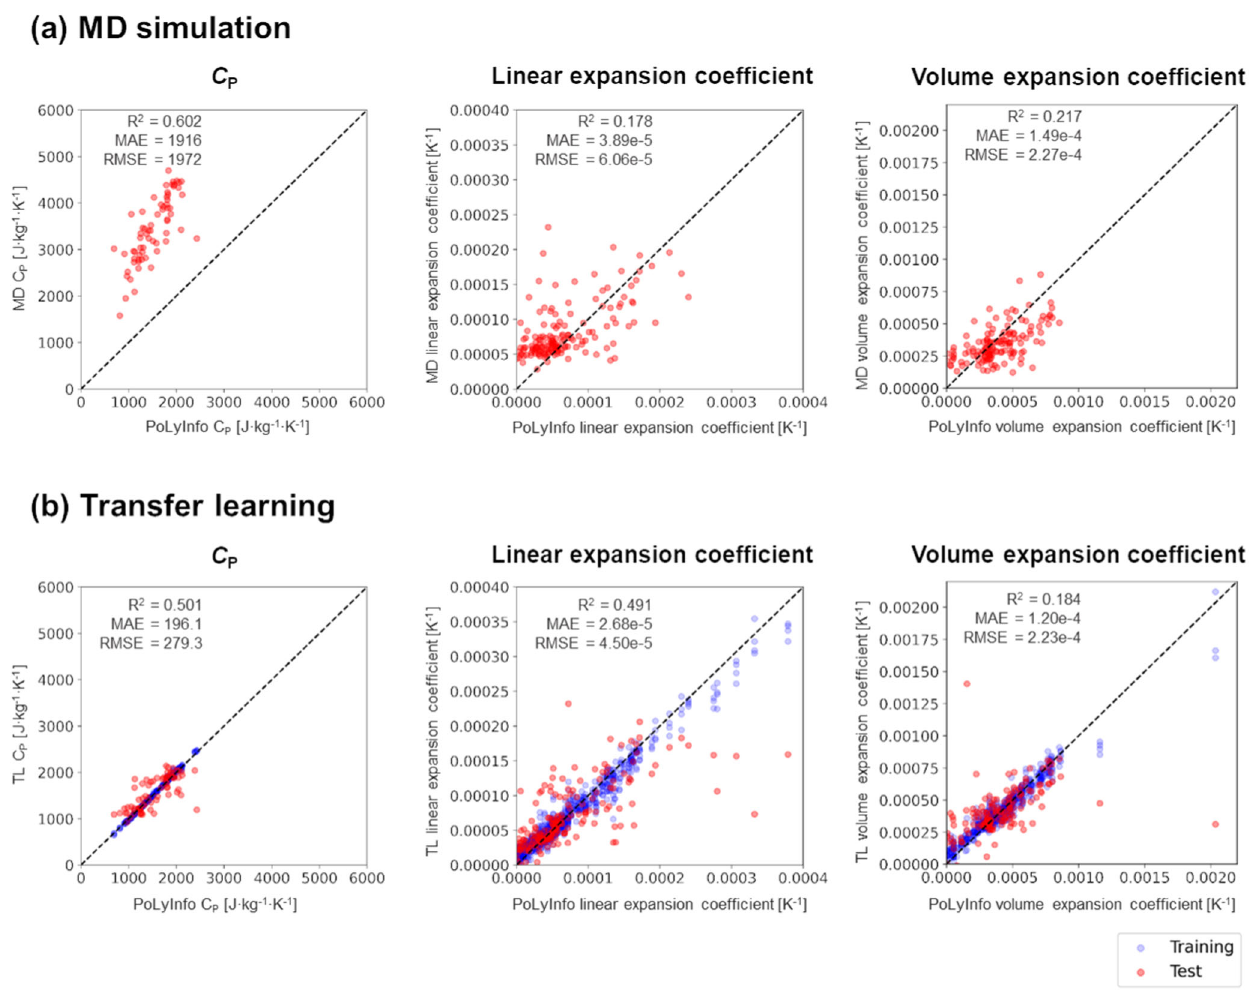
Fig. 8 Comparison of the predictive performance of MD simulation and transfer learning. The parity plots of ( a ) MD simulation and ( b ) transfer learning for experimental values of speci fi c heat capacity ( C P ), linear expansion coef fi cient, and volume expansion coef fi cient. The experimental and predicted values are shown on the horizontal and vertical axes, color-coded by red (blue: fi ts to the training data for transfer learning). Table 2. Comparison of prediction performance on the PoLyInfo experimental dataset between the MD simulations and the machine learning model based on transfer learning (TL).